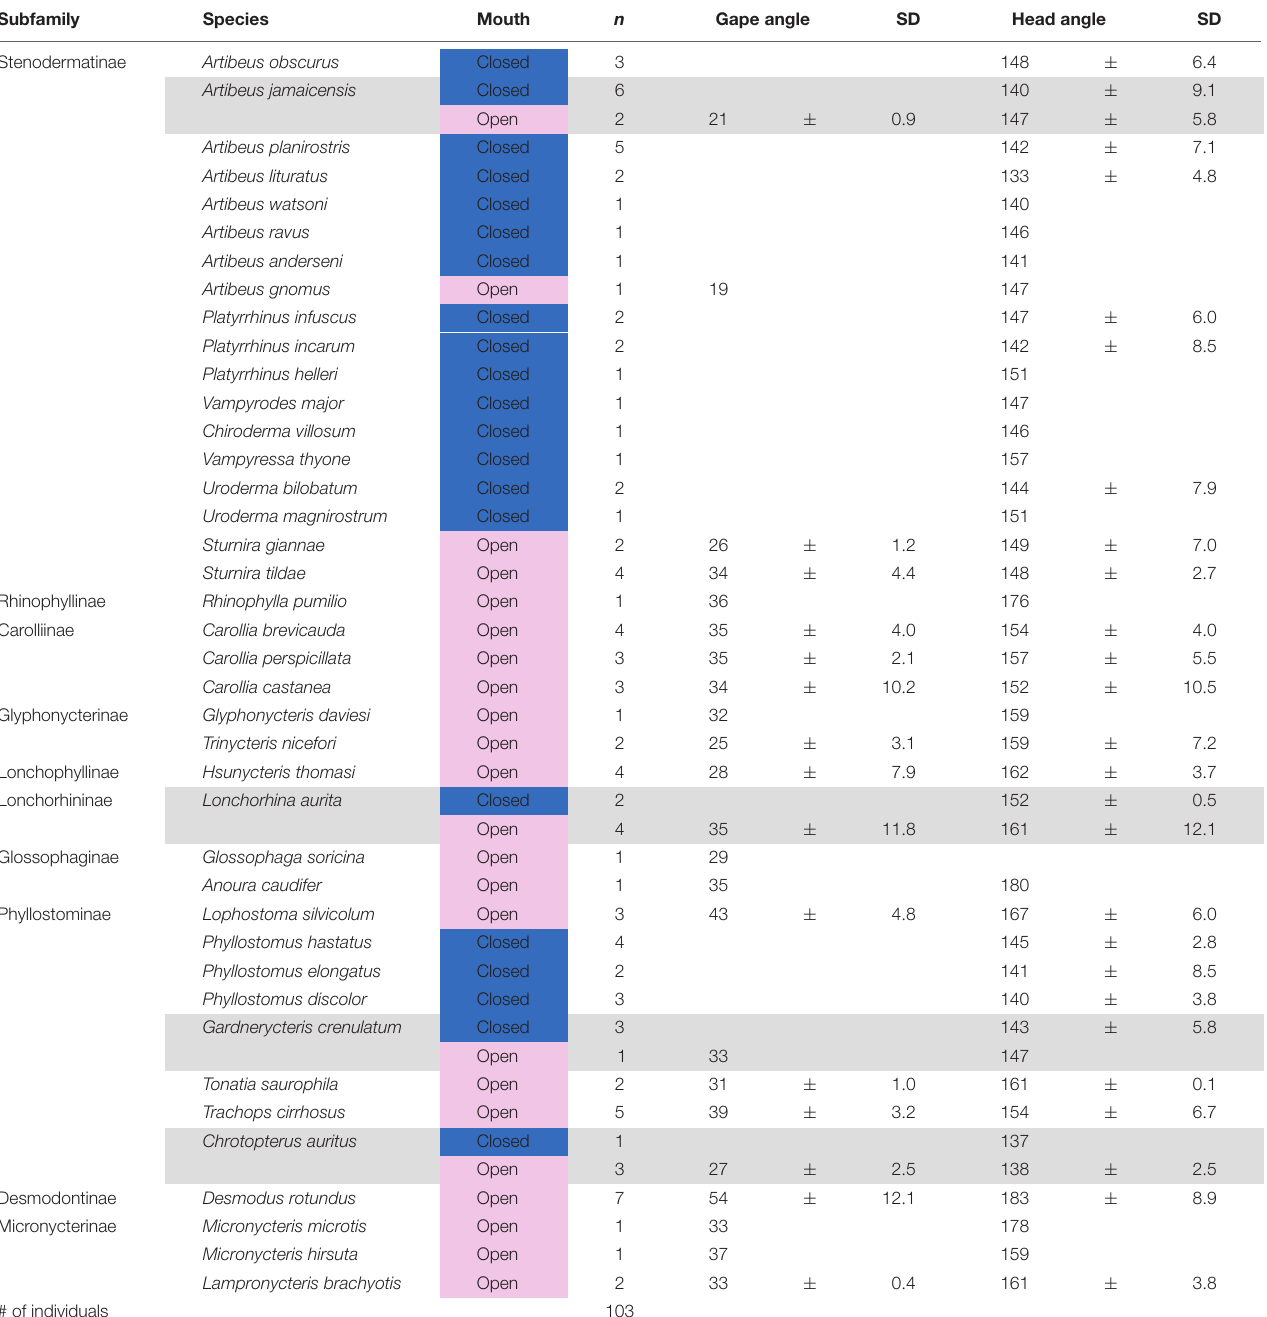
TABLE 2 | Mean gape angle in degree [ ◦ ] of 23 species and head position angle of 40 species of phyllostomid bats. Nasal emitters had their mouth consistently closed and no gape angle could be measured. Gray background indicates that individuals of this species were observed with open and closed mouth. For Glossophaga soricina no head position angle could be measured. n is the number of individuals. SD is the standard deviation.